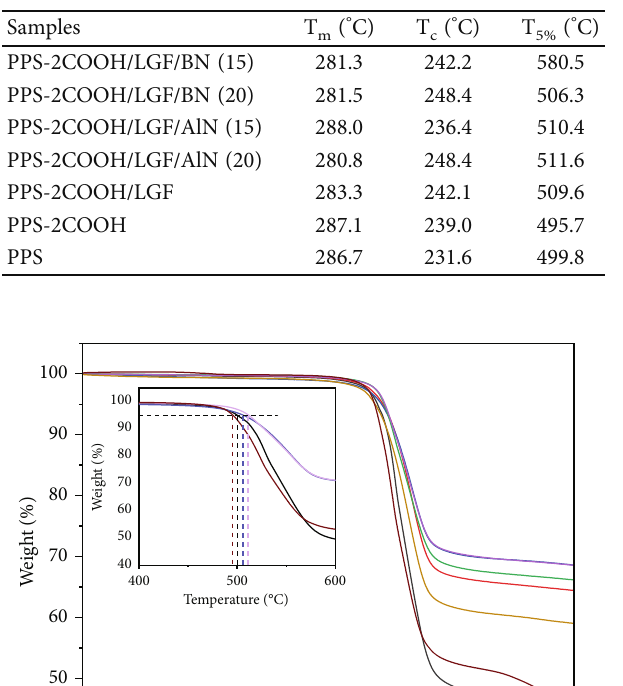
Figure 6: DSC curves of PPS, PPS-2COOH, PPS-2COOH/LGF/BN, and PPS-2COOH/LGF/AlN in a nitrogen atmosphere. Table 2: Thermal properties of the PPS-2COOH/LGF/AlN and PPS-2COOH/LGF/BN